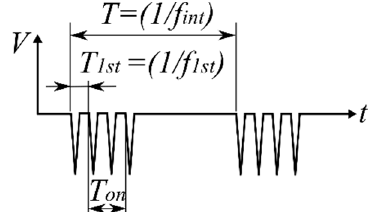
Figure 2. The input signal to the plasma actuator for the burst operation.